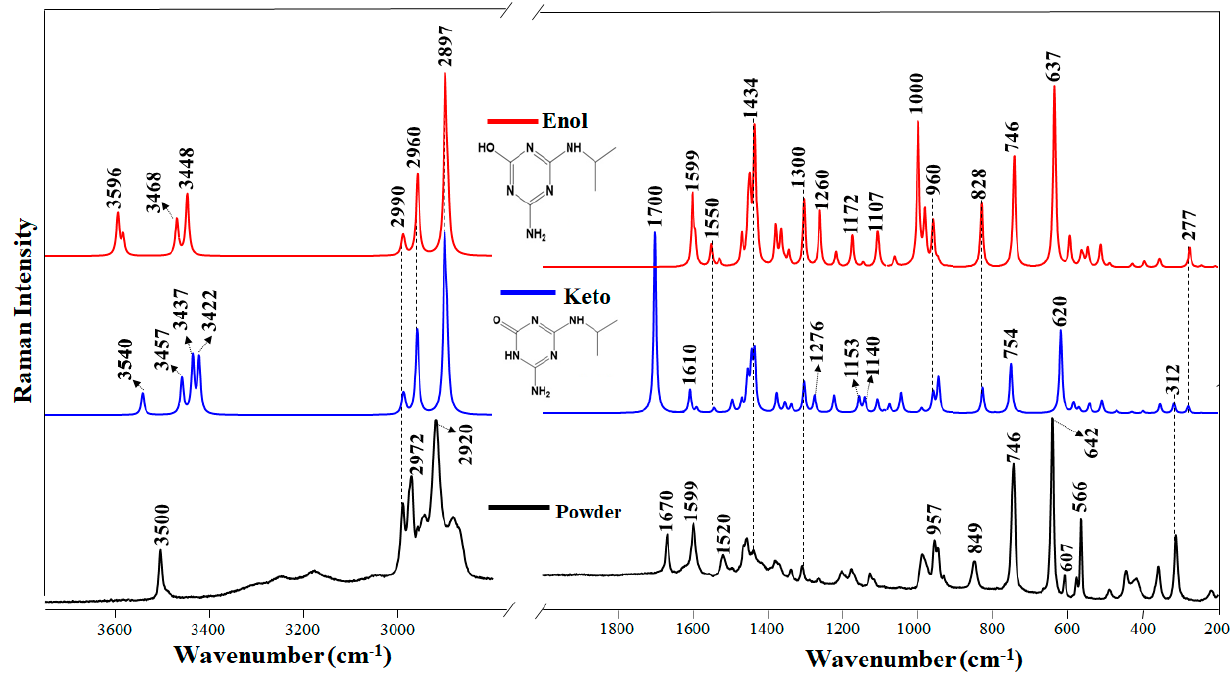
Figure 1. Raman spectrum of the DEHA powder and DEHA calculated spectra in keto and enol form.